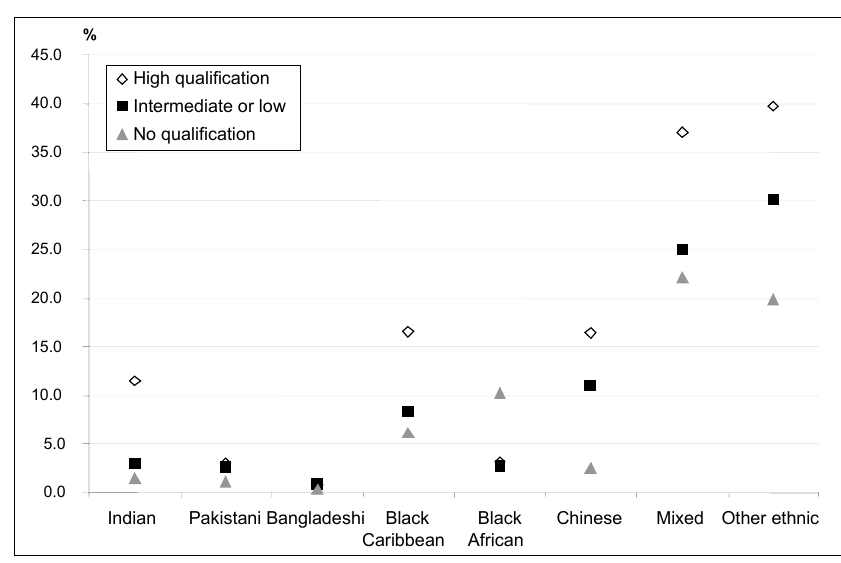
Figure 3: Predicted probability of interethnic unions with a White British partner for ethnic minority